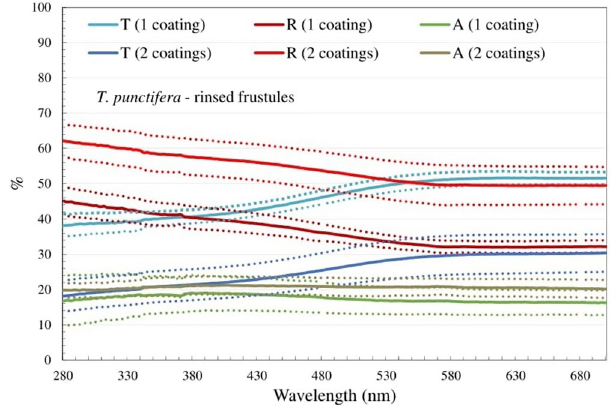
Figure 4. Spectral transmittance, reflectance and absorbance for the one layer (thickness = 18.1 ± 14.7 µ m) and two layers (thickness = 36.2 ± 19.6 µ m) coated film with rinsed T. punctifera frustules. The dotted lines represent the mean value ± the standard deviation. The reference spectrum is the UV-transparent quartz silica microscope glass plate with nothing on top of it. All the values are normalized to 100%